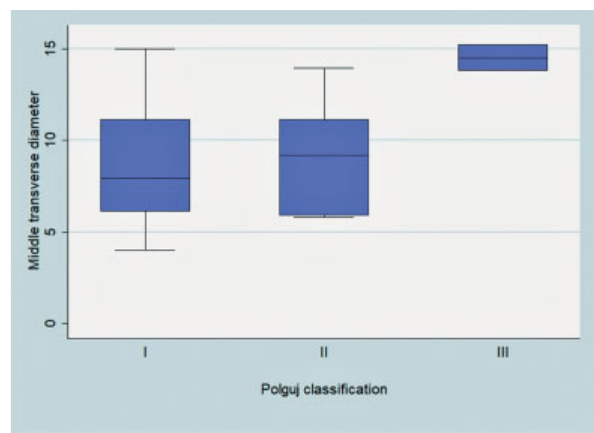
Fig. 5 Variance of SN middle-transverse diameter depending on SN content type according to Polguj ’ s classi fi cation.